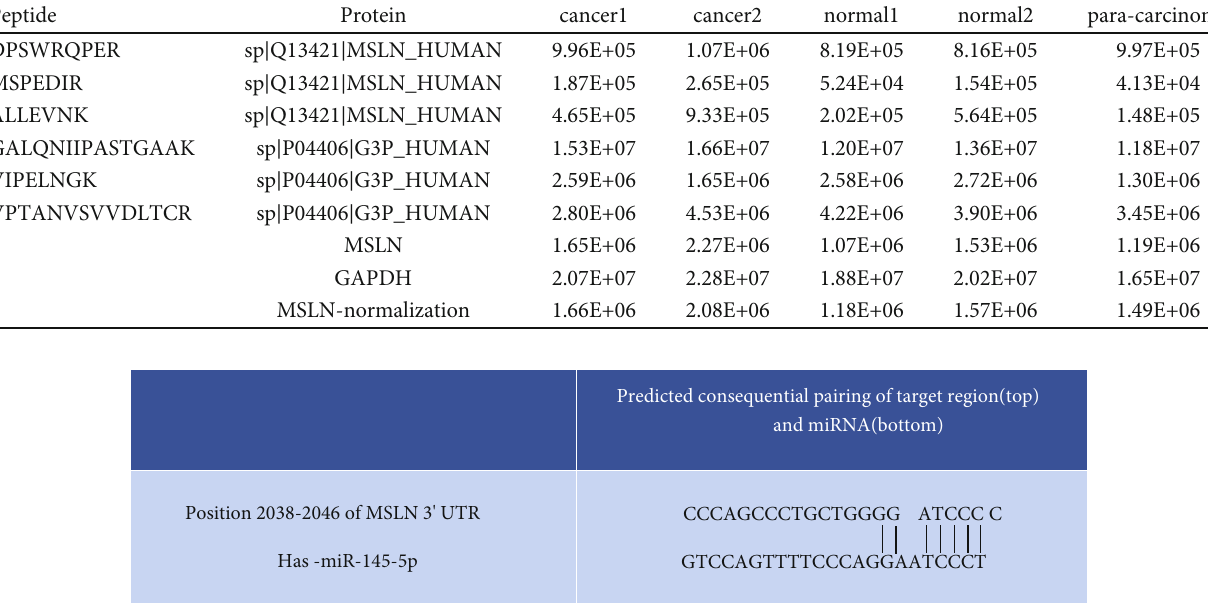
Figure 3: Prediction of the target of has-miR-145-5p through the binding site. Putative binding sites of has-miR-145-5p in the MSLN 3 ′ UTR predicted by